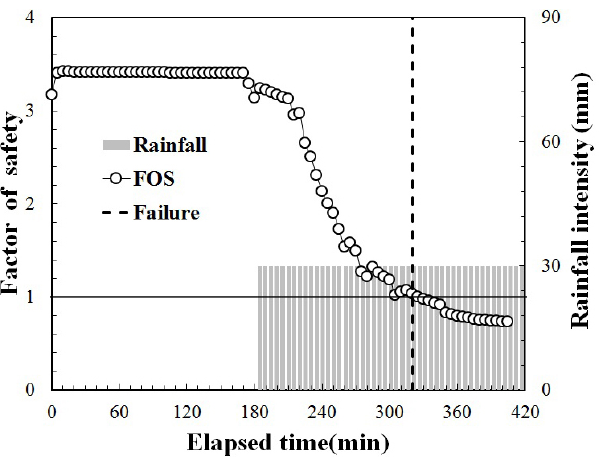
Figure 11. Factor of safety with time.